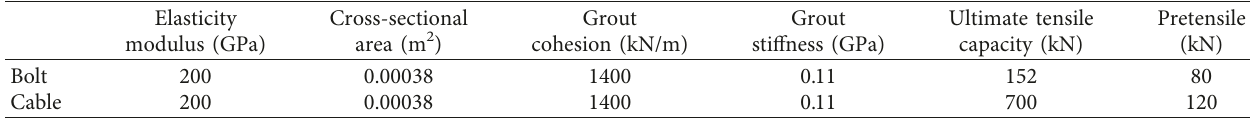
Table 4: Material parameters for bolts and cables.